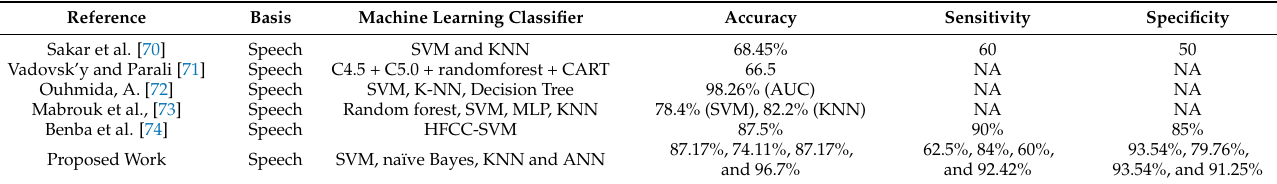
Table 8. Performance Comparison with previous studies.